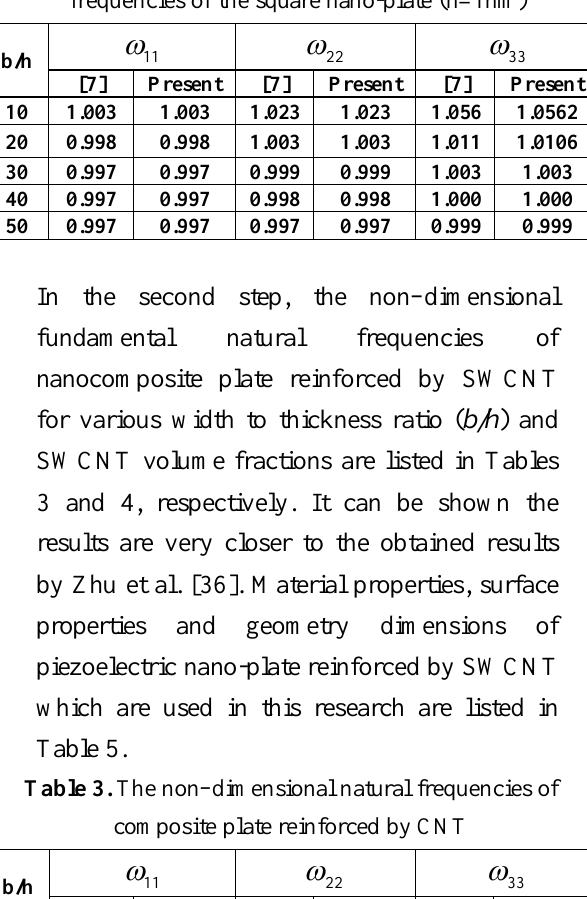
Table 2. The non–dimensional